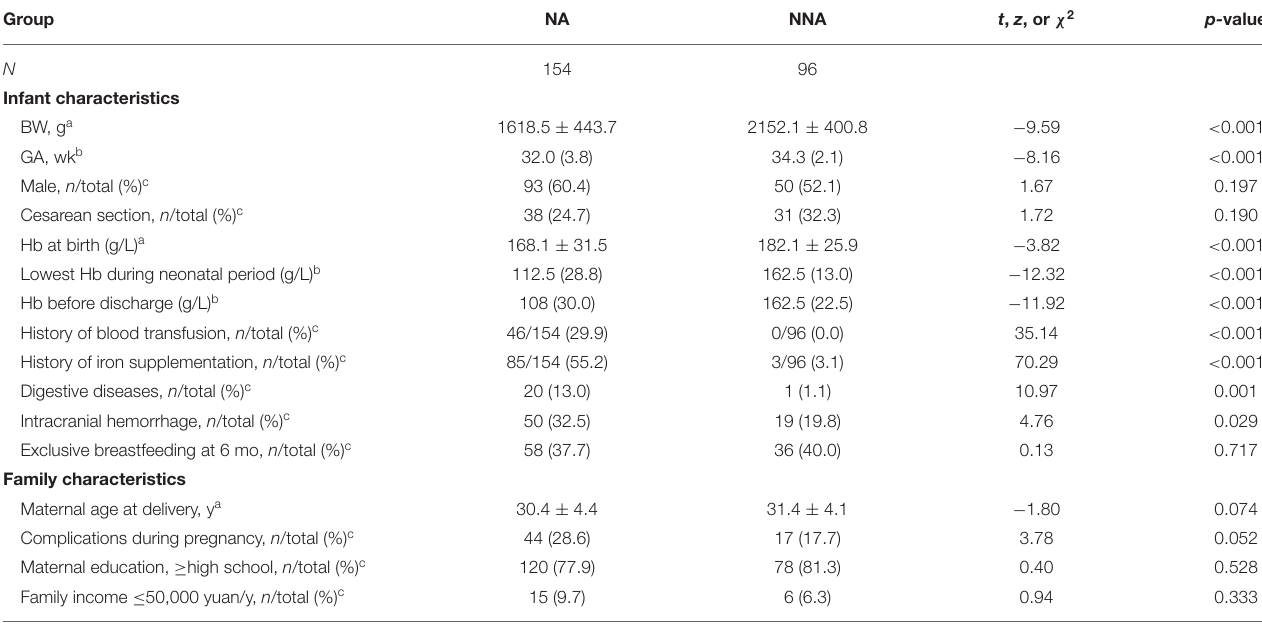
TABLE 1 | Infant and family characteristics by group.